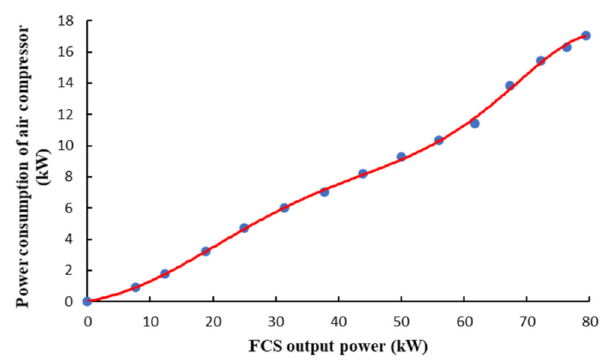
Figure 4. The power consumption curve of the air compressor.